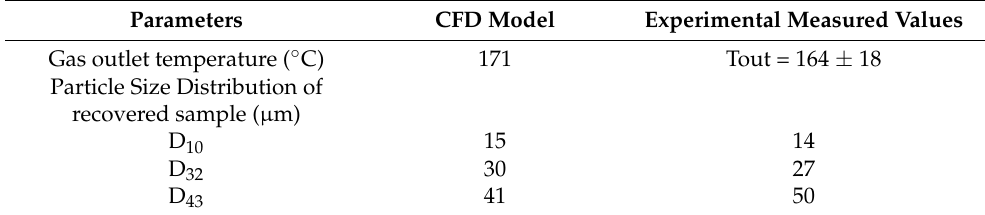
Table 2. Comparison of model predictions against experimentally measured